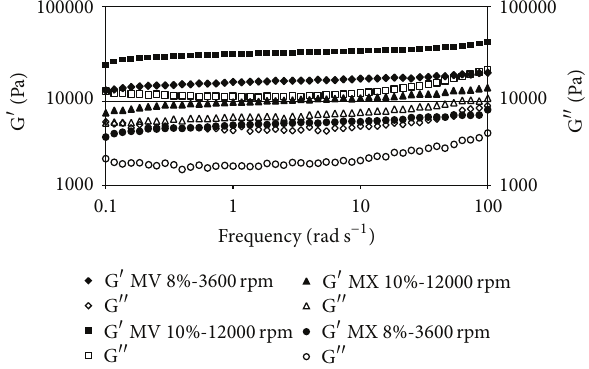
Figure 2: Frequency sweep comparison of corn oil samples. 𝐺 󸀠